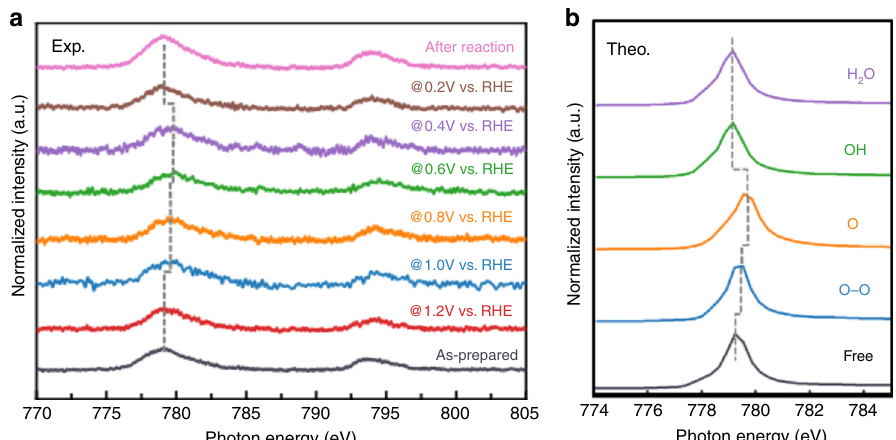
Fig. 3 In situ experimental and theoretical calculation data of Co L-edge X-ray absorption. a Co L 3,2 -edge X-ray absorption near edge spectra (XANES) of the py-B12/C catalyst at various operando biases. b FEFF calculated Co L-edge with different